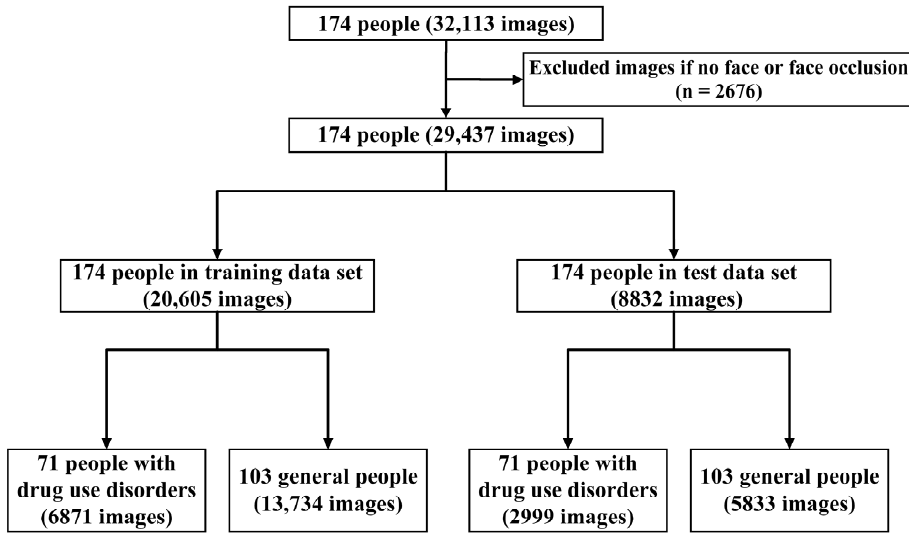
Figure 2. The flow of data source and datasets collection.